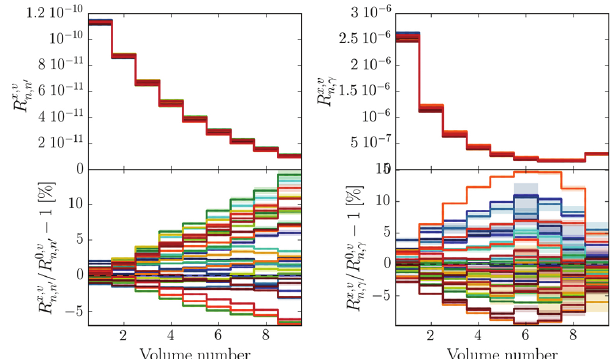
Fig. 8. Reaction rate dispersion in the foil detectors for the indium inelastic (top-left) and capture (top-right) reactions, the difference between each ACE file and the first ‘reference’ ACE file being represented in colours (bottom).